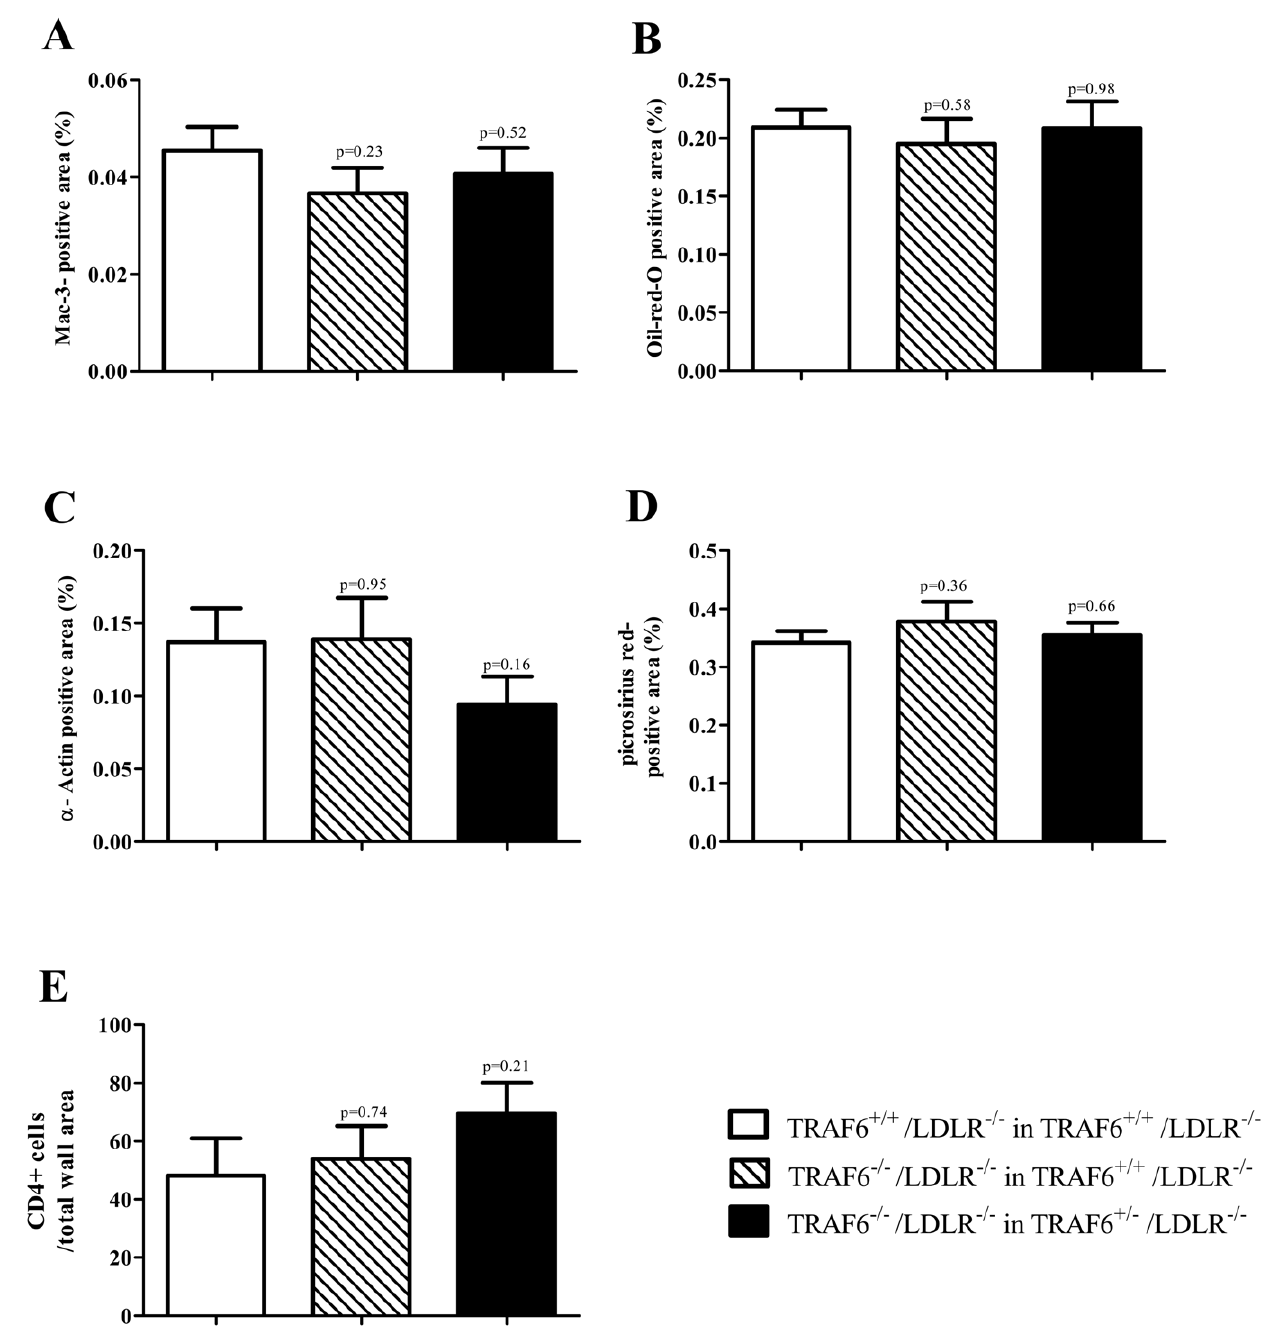
Figure 5. TRAF6 deficiency does not alter plaque composition. Lethally irradiated 6 week old TRAF6 + / + /LDLR 2 / 2 mice received TRAF6- deficient (hatched bars, N=21) or competent fetal liver cells (white bars, N=21), TRAF6 + / 2 /LDLR 2 / 2 mice received TRAF6-deficient fetal liver cells (black bars, N=22) only. Subsequently, all groups consumed high cholesterol diet (HCD) for 18 weeks. Sections of the aortic roots were analyzed for macrophage- (A), lipid- (B), smooth muscle cell- (C), collagen (D), and T cell-content (E). Mac-3-, oil-red-O-, a -actin-, picrosirius red, and CD4-positive staining in per cent of total wall area is displayed as mean 6 SEM.